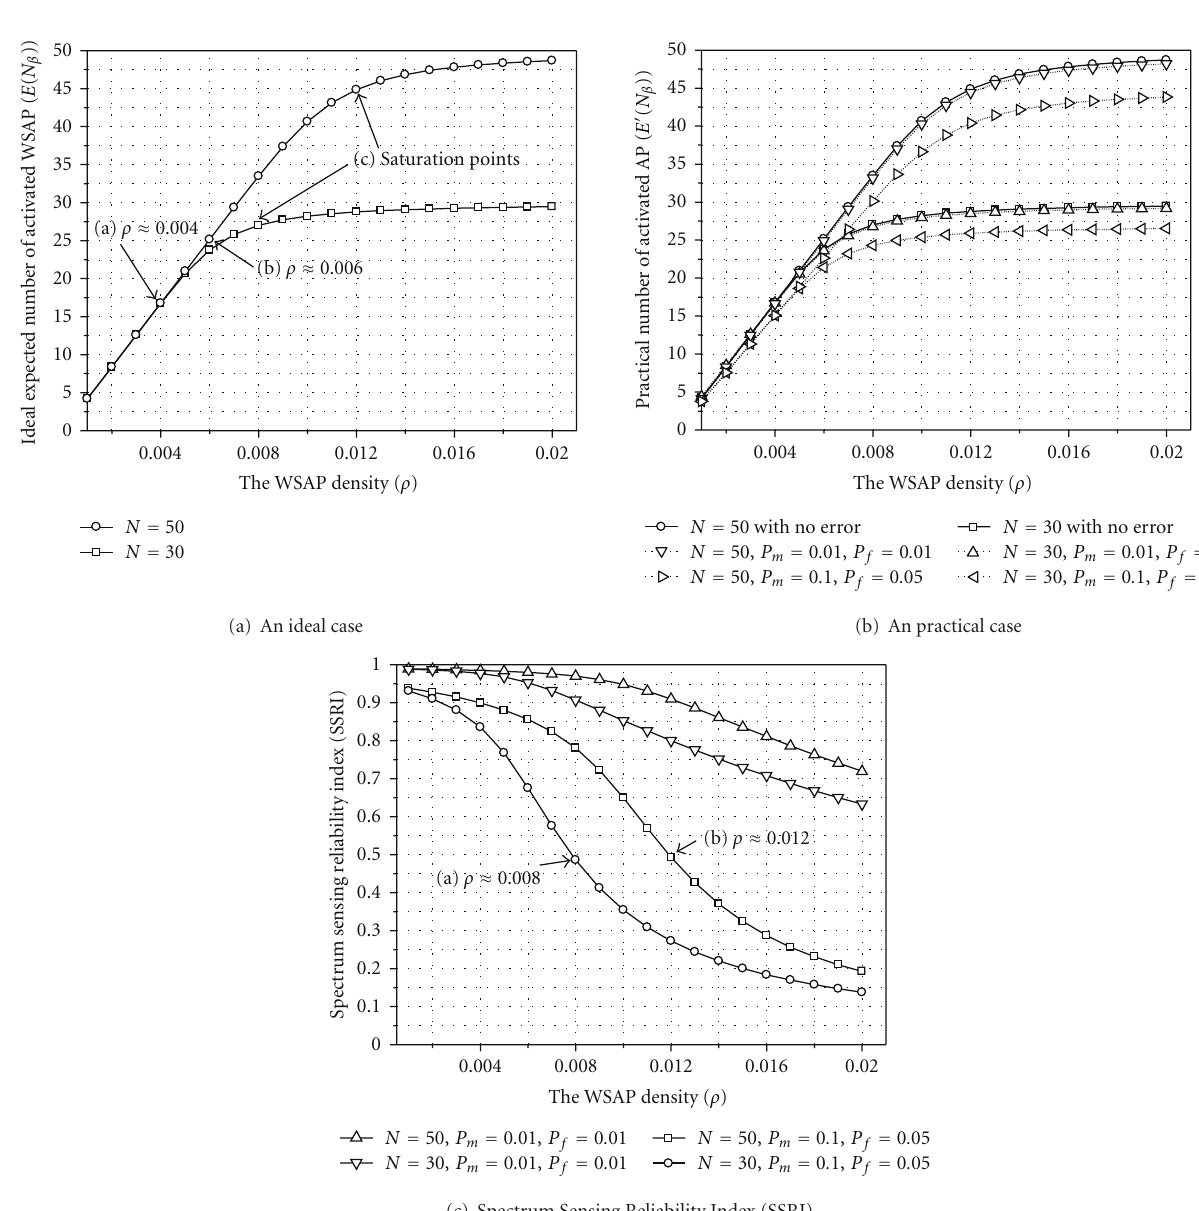
Figure 5: The expected number of activated WSAPs with R = 120 m and errorless spectrum sensing techniques when the density of WSAPs ( ρ ), the average rate of the service time ( μ ), and the expected number of activated WSAPs, E ( N β ), are known (Subfigure (a)). versus the expected number of activated WSAPs with erroneous spectrum sensing techniques (Subfigure (b)). Subfigure (c) depicts the extent to